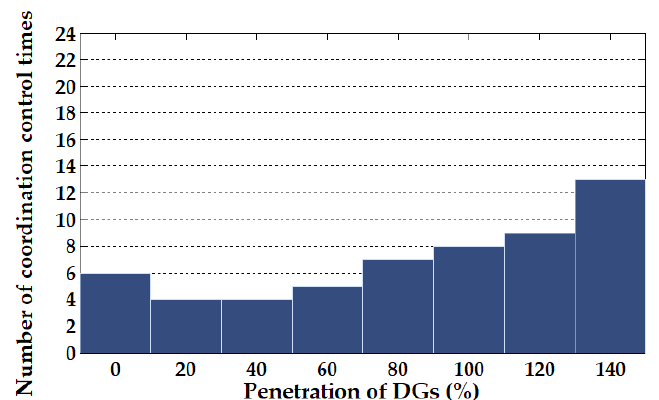
Figure 9. Number of coordination control times in scenario 3 with di ff erent DG penetrations.